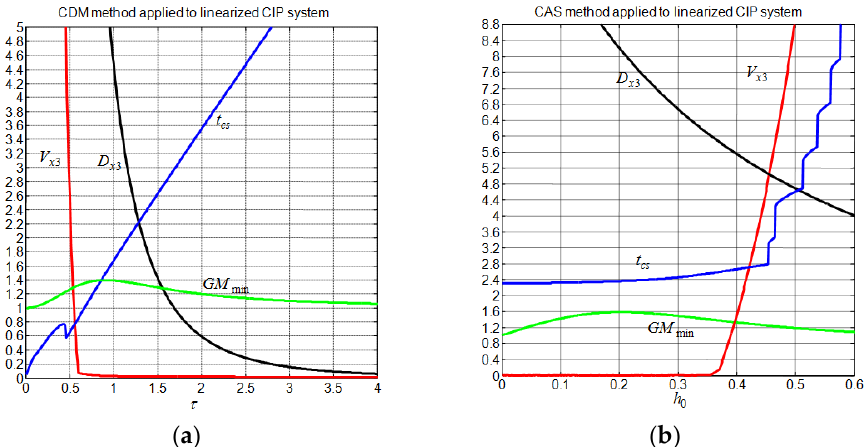
Figure 9. Evolution of the system gain margin and the cart response performance. ( a ) CDM method; ( b ) CAS method.